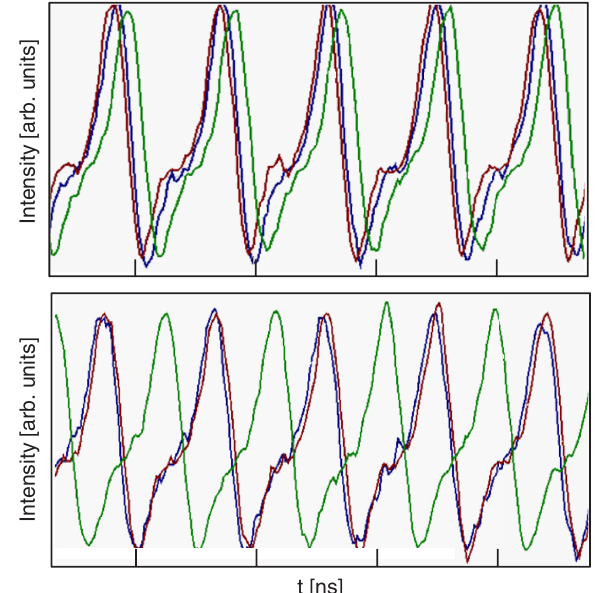
FIG. 8. First rf acceleration with CH cavity; measured Ar 11 þ - phase probe signals from HLI beam at 1 . 366 MeV/u (top), rf frequency is 108.408 MHz (T ¼ 9 . 224 ns). By acceleration up to the nominal beam energy (bottom), the coarse time of flight between the blue and the red signal is slightly reduced. The time of flight for the fine measurement between the red and the green signal is significantly shifted, according to the beam energy of 1 . 866